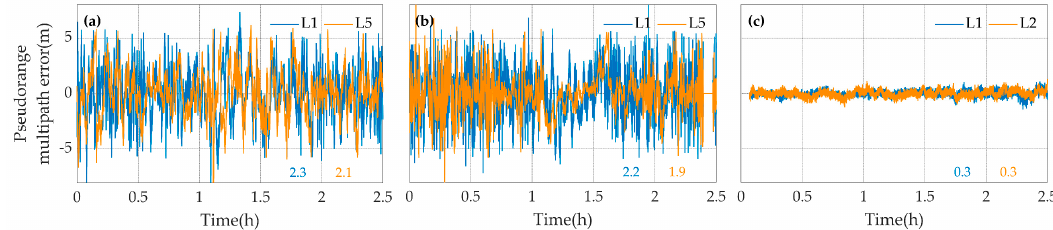
Figure 9. The standard deviations of L1 (orange), L5 or L2 (blue) code multipath errors with the Mate30 ( a ), the V20 ( b ) and the Trimble R8 ( c ) in the first experiment.